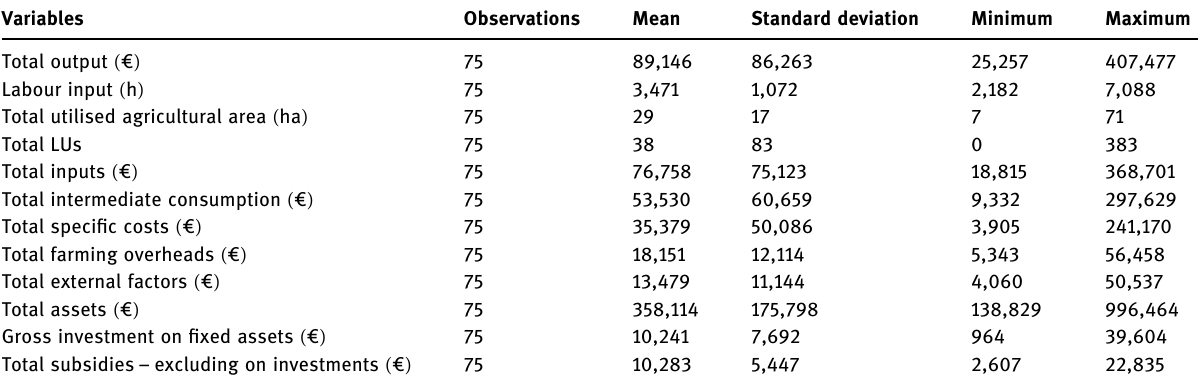
Table 7: Statistical summary for the several variables considered over the period 2014 – 2018 Variables